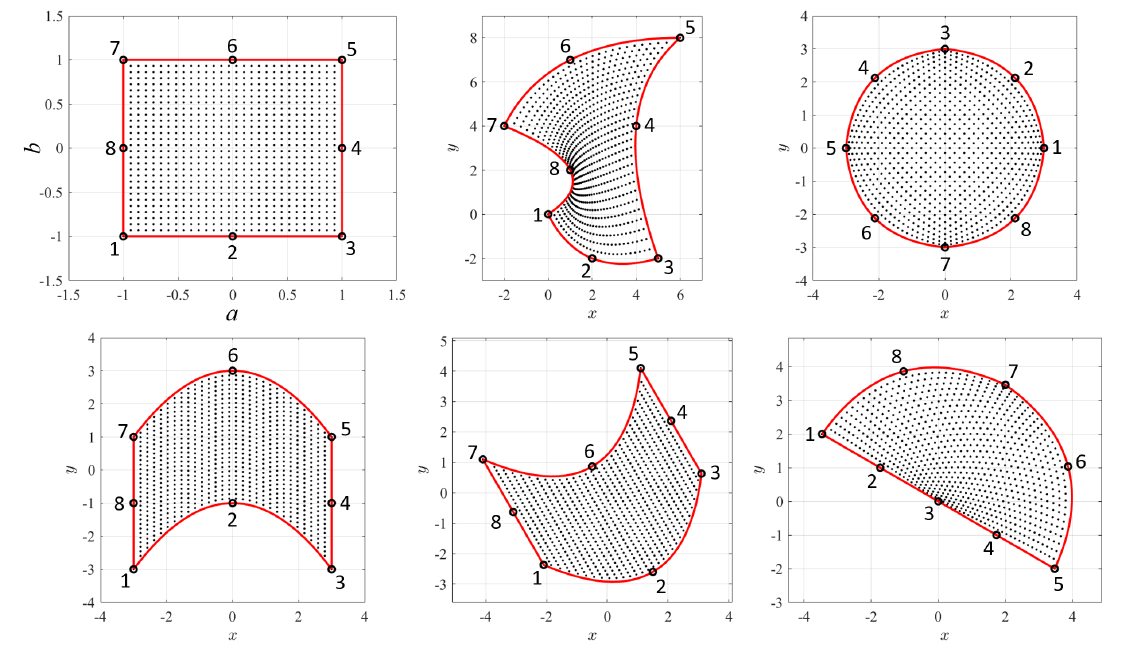
Figure 9. Polynomial mapping examples with 8 control